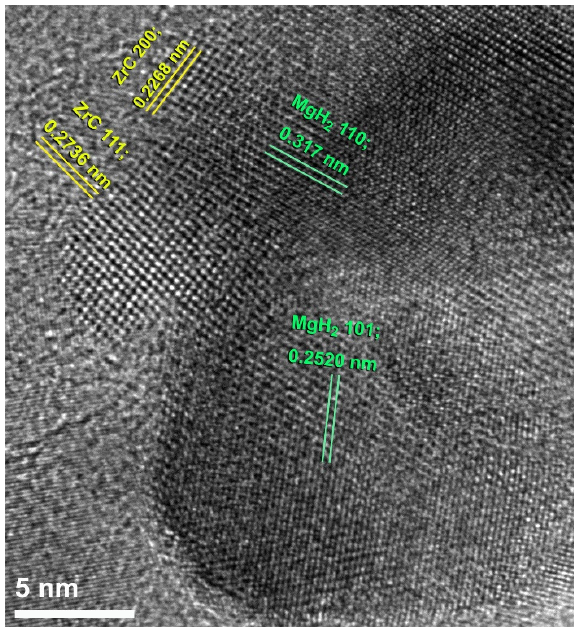
Figure 6. FE-HRTEM with atomic resolution of nanocomposite MgH 2 /5 wt.% ZrC powders obtained after 50 h of HEBM.